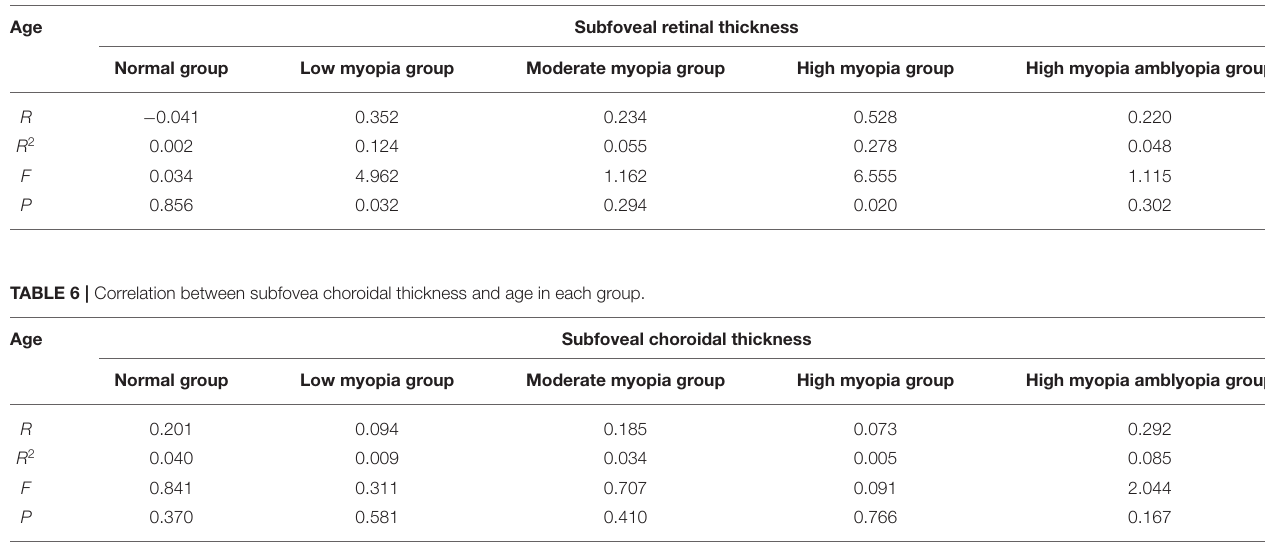
TABLE 5 | Correlation between subfovea retinal thickness and age in each group.